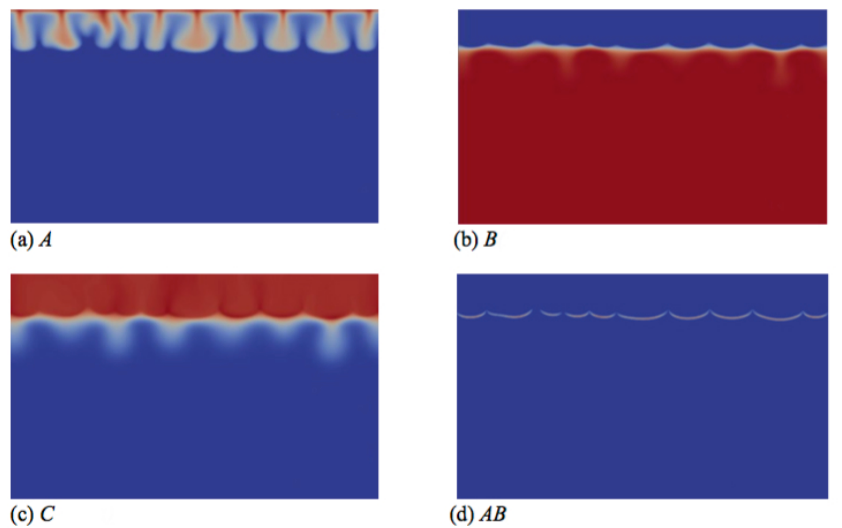
Figure 7. Concentrations fields of ( a ) A; ( b ) B; ( c ) C; and ( d ) reaction rate AB field corresponding to the density field shown in Figure 6d ( t = 26000). Concentrations scale between zero (dark blue) and one (red), while the reaction rate scales between zero (dark blue) and 0.003